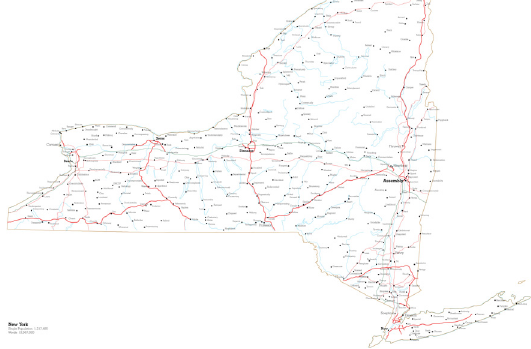
FIGURE 2 | R. Luke DuBois, A More Perfect Union: Lonely (2011). Pigment-ink on photo rag. 18 x 24”/ 46 x 61 cm. Courtesy R. Luke DuBois and bitforms gallery, New